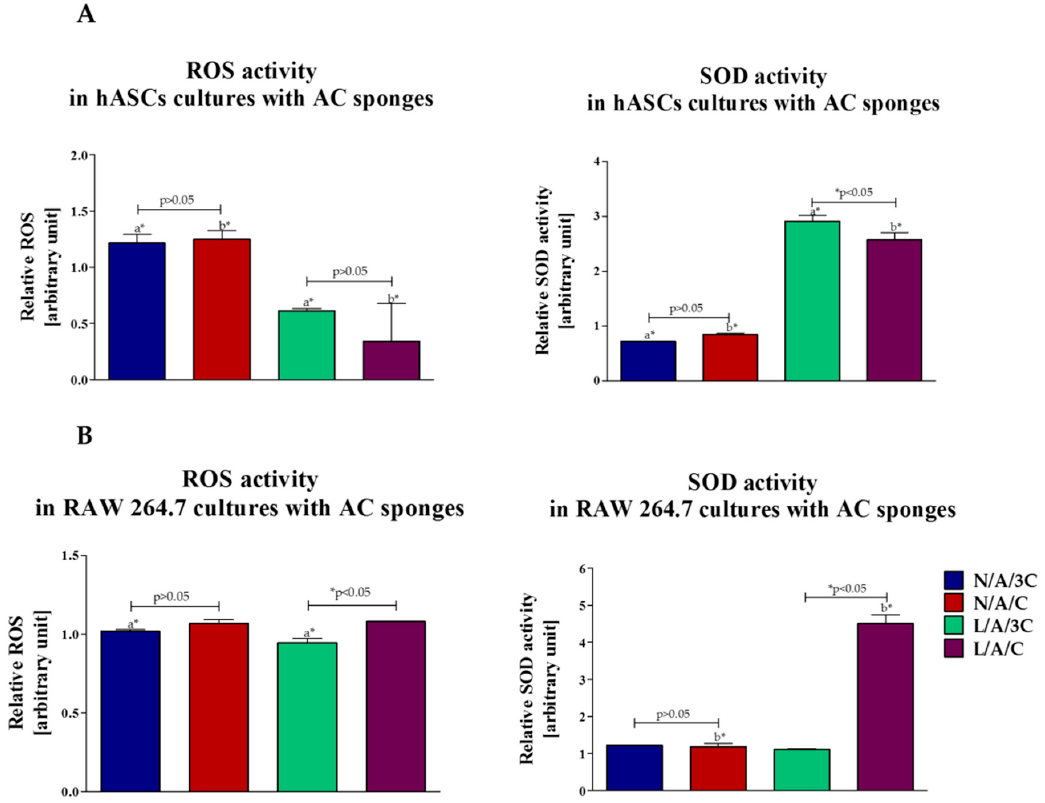
Figure 11. Analysis of oxidative stress factor in hASCs ( A ) and RAW264.7 ( B ): reactive oxygen species (ROS) and superoxide dismutase (SOD). An asterisk (*) represents statistically significant differences ( p ˂ 0.05).